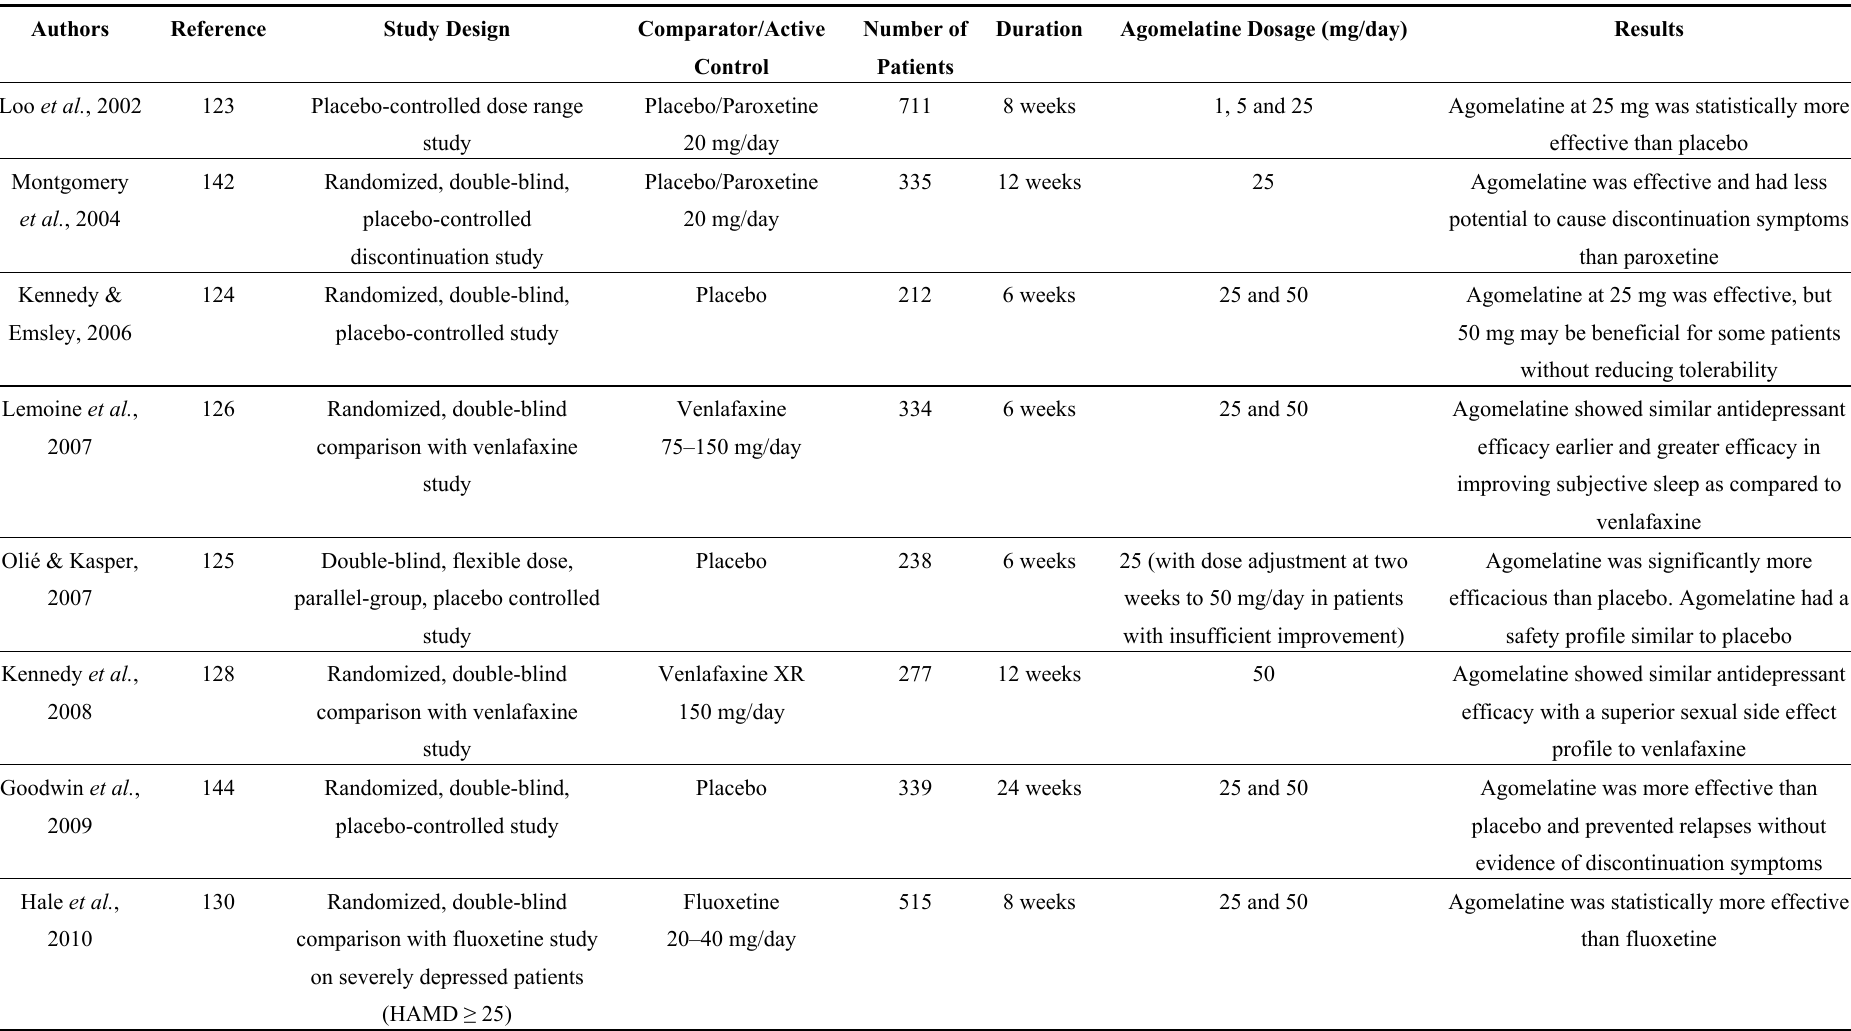
Table 1. Published placebo-controlled and/or active comparator studies of agomelatine in the treatment of major depression. HAMD, Hamilton Depression Rating